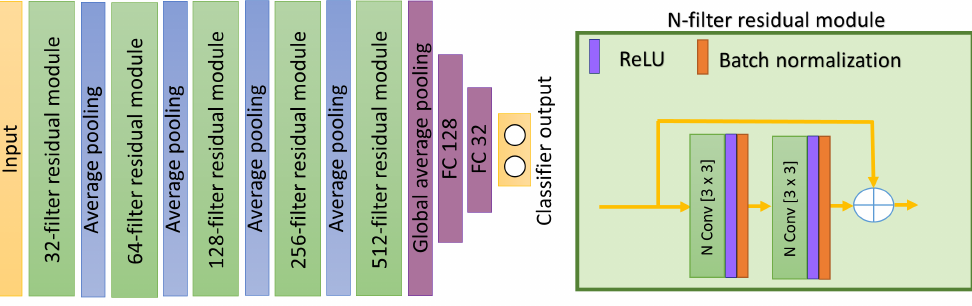
Figure 2. Schematic overview of the classification branch of the designed deep learning